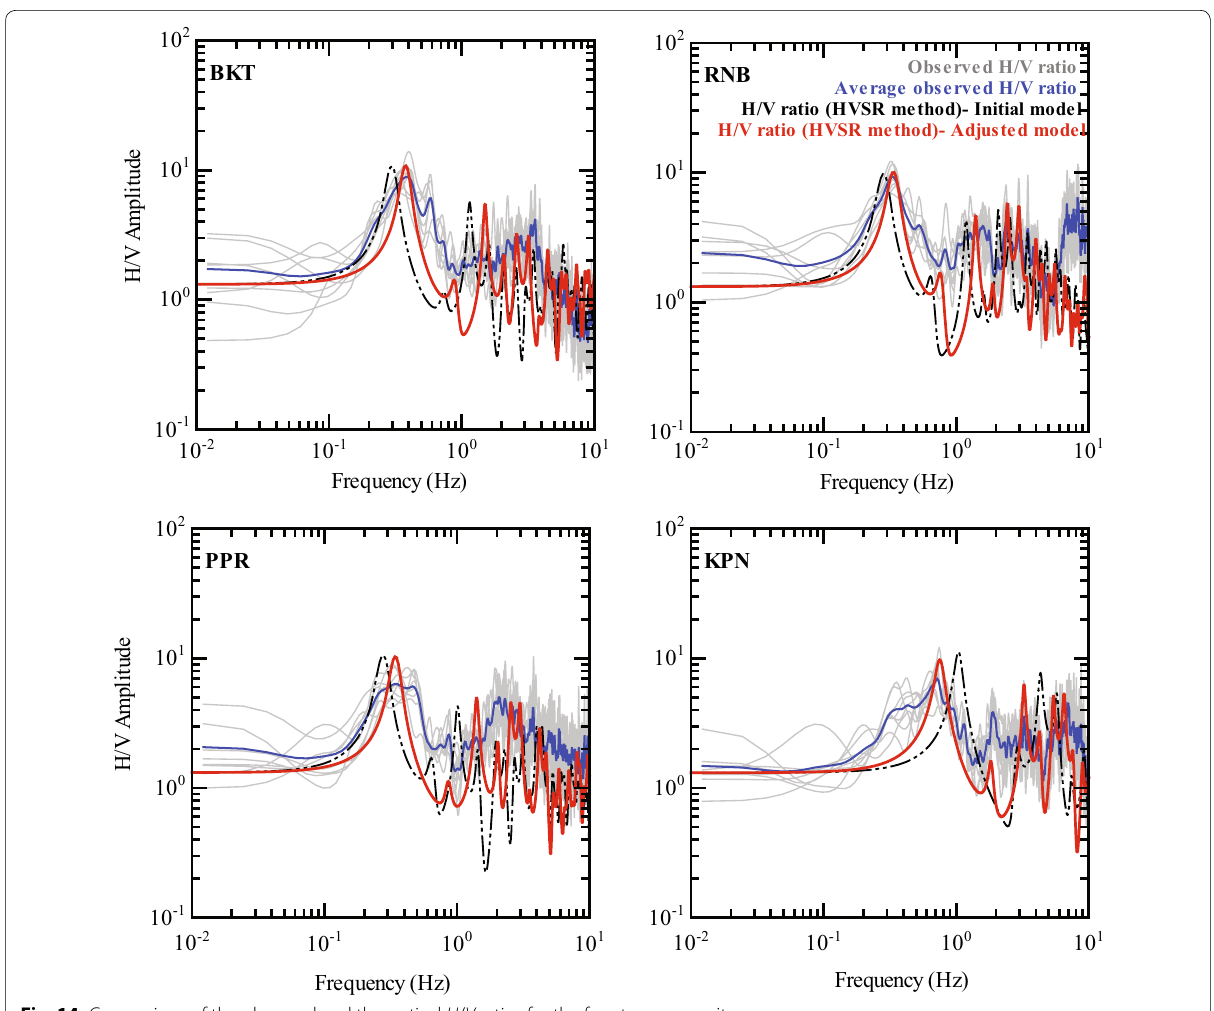
Fig. 14 Comparison of the observed and theoretical H / V ratios for the four temporary